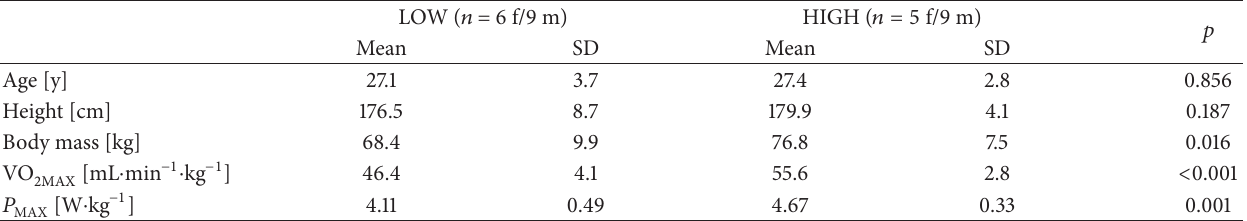
Table 1: Anthropometric data, maximal oxygen consumption, and maximal power of HIGH and